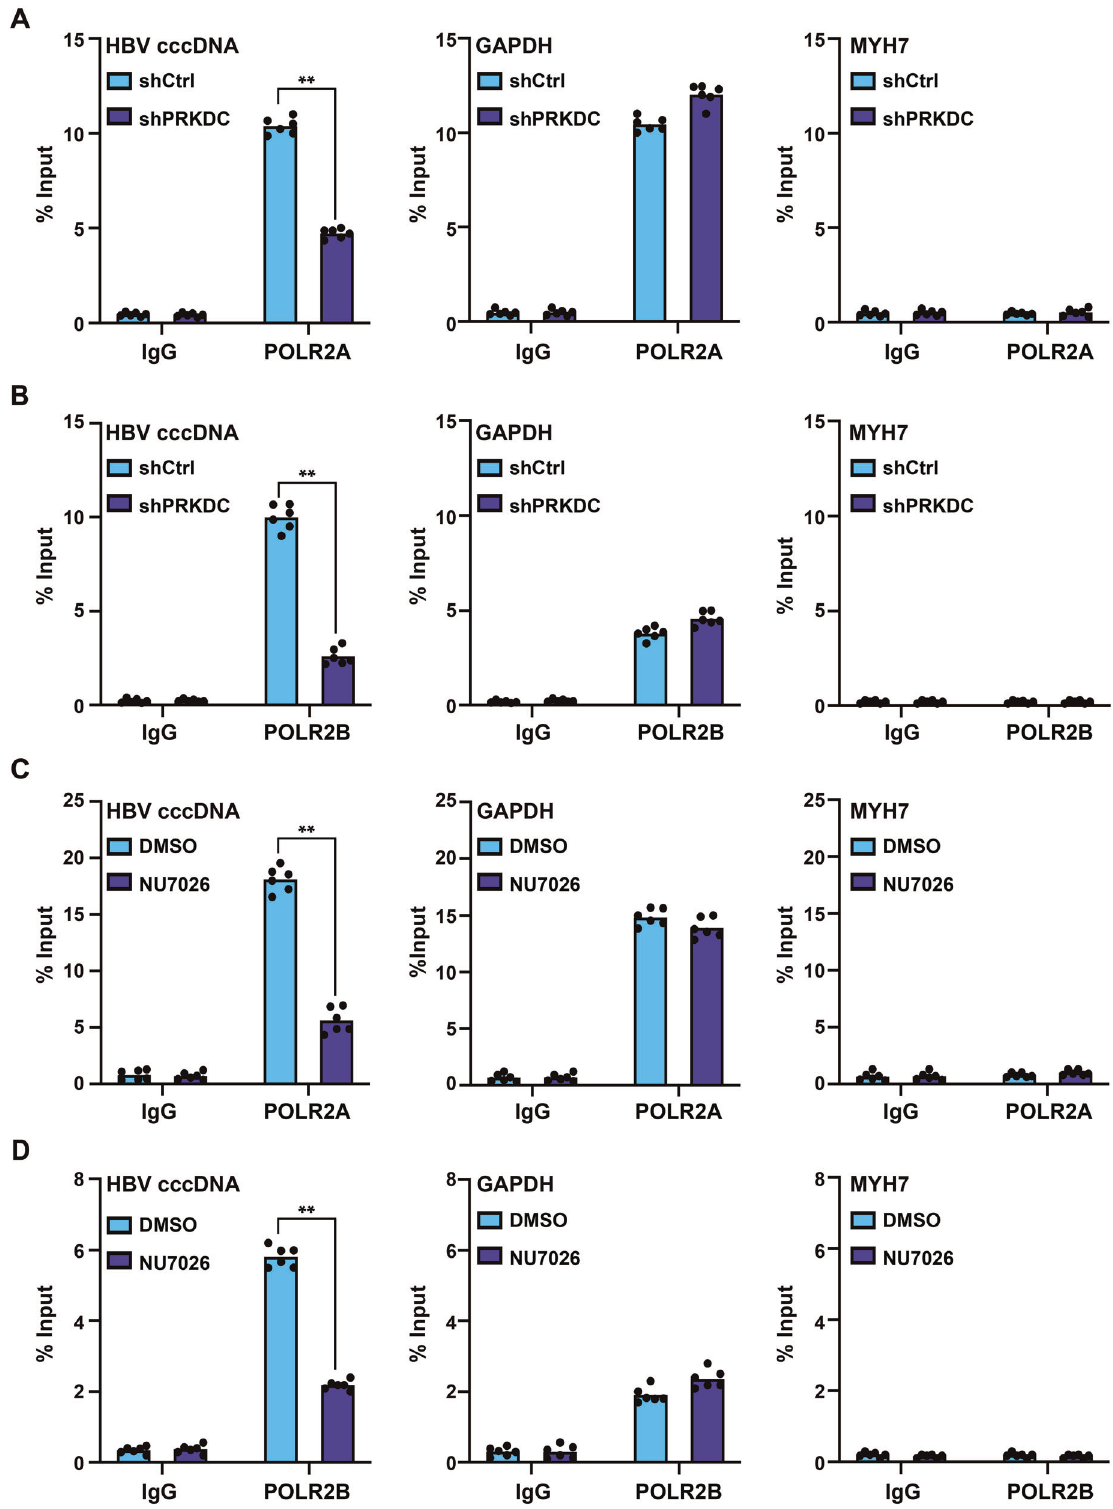
Fig. 6 PRKDC knockdown and NU7026 treatment inhibits the binding of POLR2A and POLR2B to HBV cccDNA. HBV-infected HepG2-NTCP cells were treated with PRKDC shRNAs or NU7026, and then cross-linked with 4% formaldehyde solution, sonicated, and immunoprecipitated with indicated antibodies. Levels of POLR2A ( A ) or POLR2B ( B ) associated with HBV cccDNA or the GAPDH or MYH7 promoter upon PRKDC knockdown were determined by qPCR. The effect of NU7026 treatment on the recruitment of POLR2A ( C ) or POLR2B ( D ) to cccDNA or the GAPDH or MYH7 promoter was examined by ChIP-qPCR. The results are displayed as the percentage of input. ** P < 0.01.